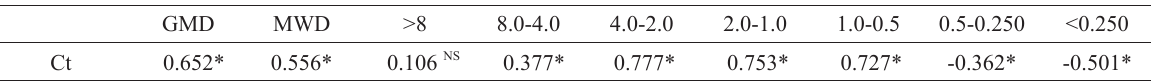
Correlation coefficient of the geometric mean diameter (GMD) and mean weight diameter (MWD) of aggregates of diameter >8.00, 8.00-4.00, 0.50-0.25 and <0.25 mm with carbon concentration (kg m -2 ) in a medium-textured dystrophic Red Latosol.